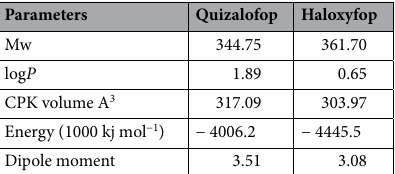
Table 3. Physicochemical properties of quizalofop and haloxyfop.